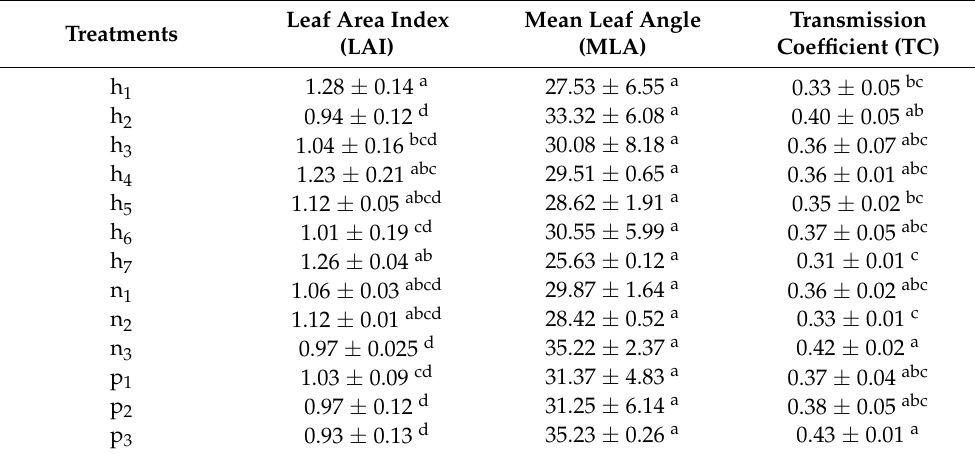
Table 3. Canopy characteristics of the trees in different fertilization treatments (mean ± SD, n = 12). Mean totals with a common letter are not different ( p < 0.05) by ANOVA for the ranking test. Leaf Area Index Mean Leaf Angle Transmission Treatments (LAI) (MLA) Coefficient (TC) h